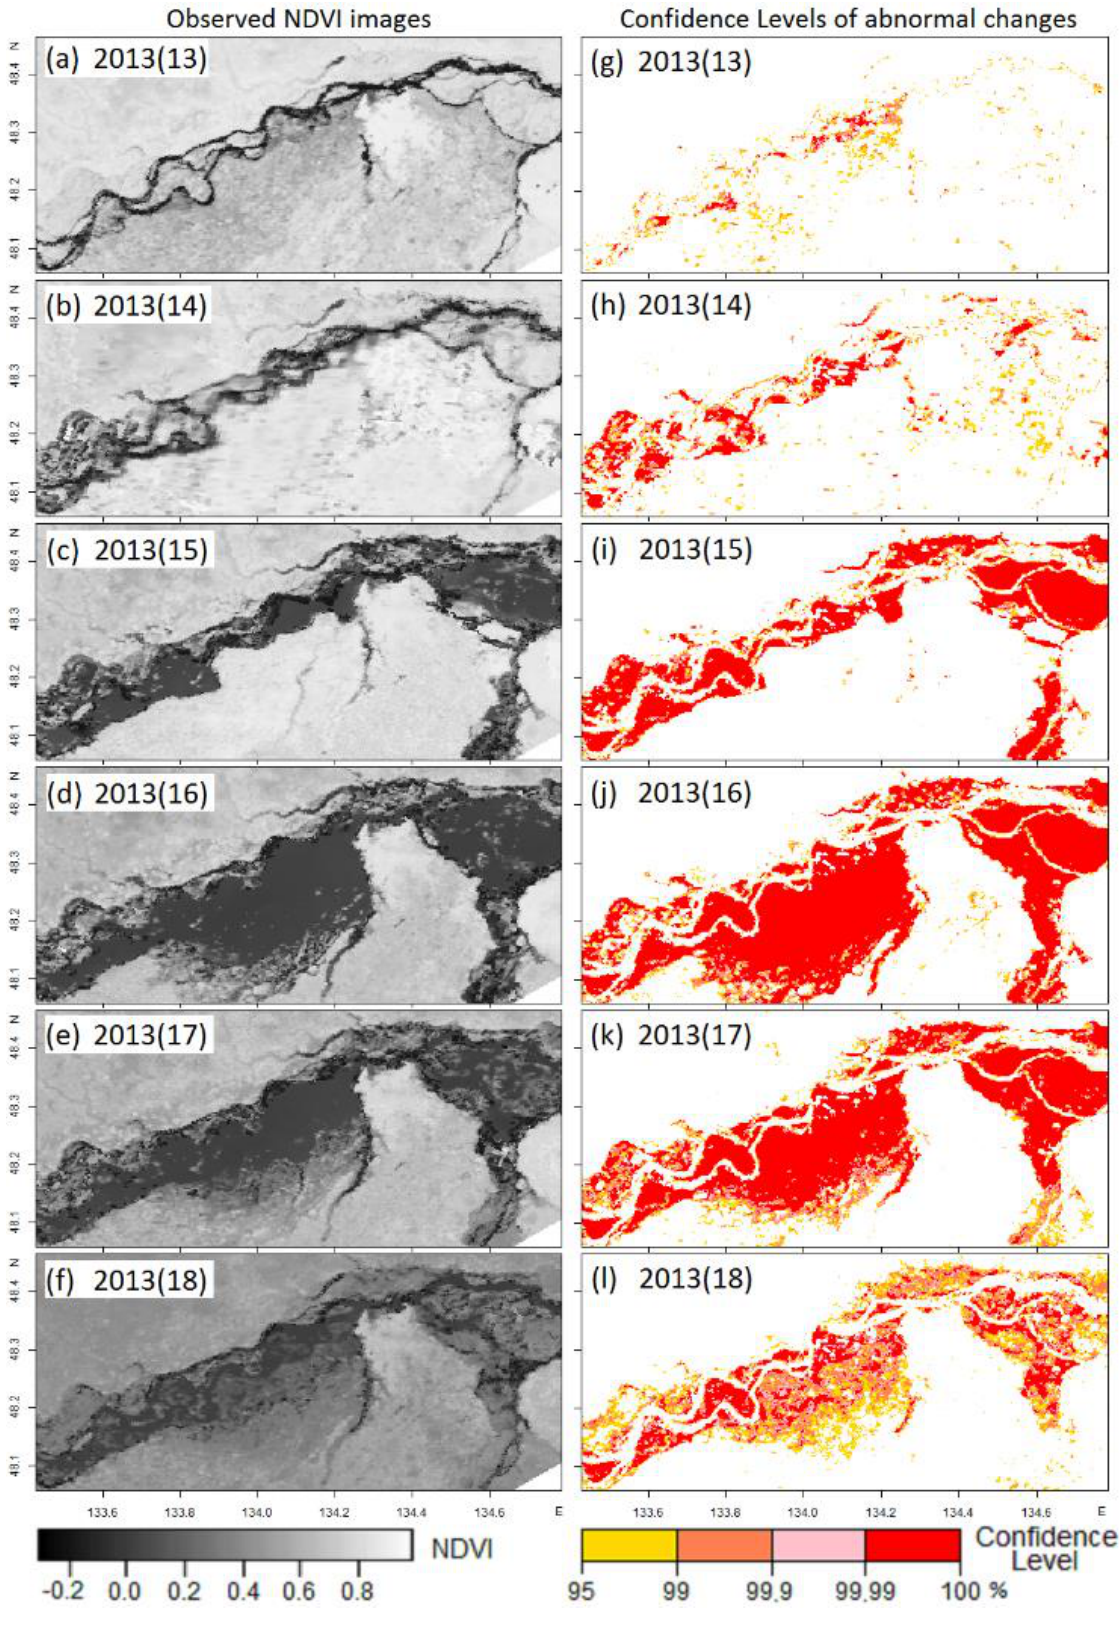
Figure 4. The MODIS NDVI image time series (a-f) during flooding period and the estimated reliability of the detected disturbance regions (unexpected flooding areas) (g-l). The number in parenthesis indicates the sequence number of the 23 16-day compositing